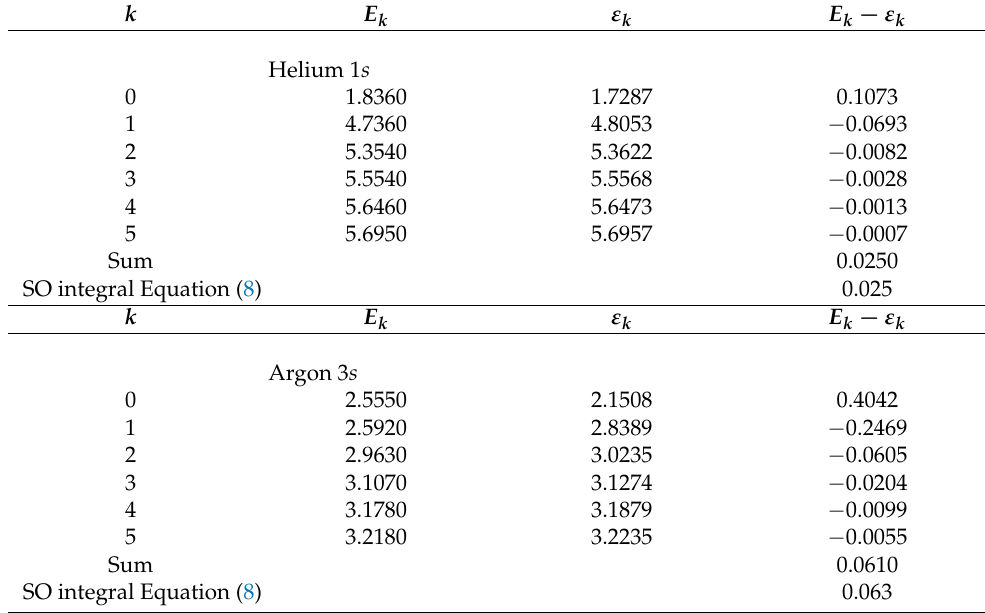
Table 2. The energies of the shake-up satellites in the photoelectron spectra of He 1 s and Ar 3 s as calculated in the HF approximation E k and as the poles of the SHGF ε k . The sum ∑ k ( E k − ε k ) in each target is compared with the corresponding time delay integral Equation